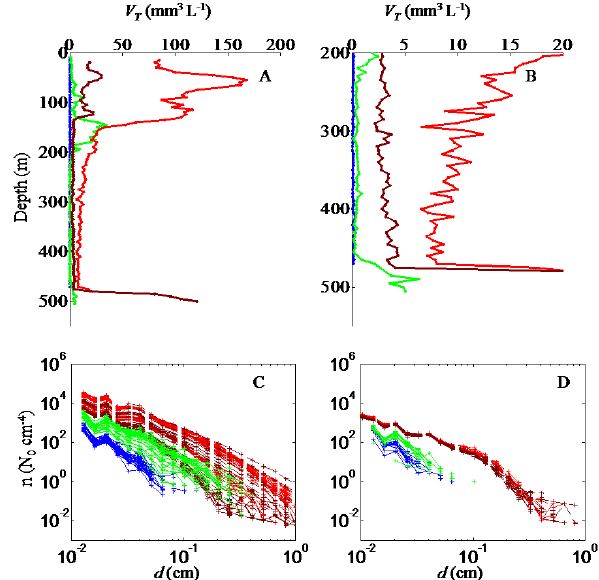
Figure 11. (A, B) Comparison of the total volume profiles mea- sured during KEOPS2 in October (A3-1, blue), November (A3-2/7, green), and during KEOPS1 in January (red) and February (brown). The depth scale for (B) is enlarged and covers only 200–500m. (C, D) Comparison of the normalized size spectra in the 0–200m (C) and 200–400m layer (D) . The colors indicate the same profiles as in (A, B)